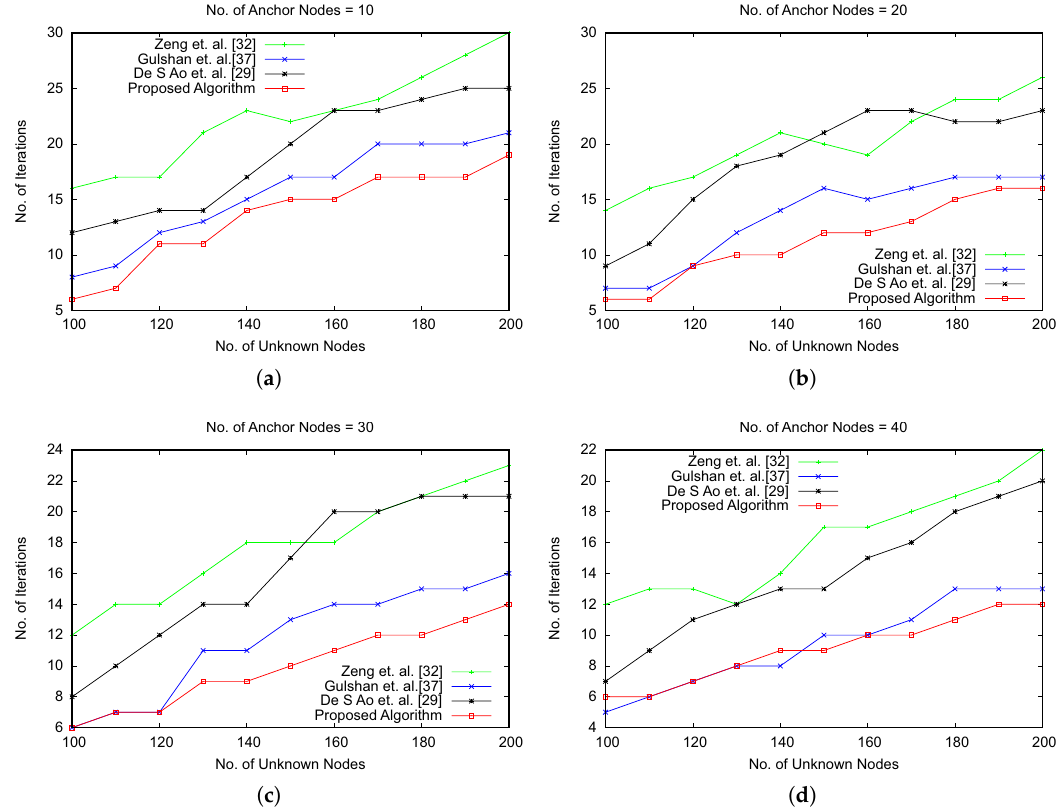
Figure 11. Comparison of iteration numbers with varying anchor nodes and unknown nodes.